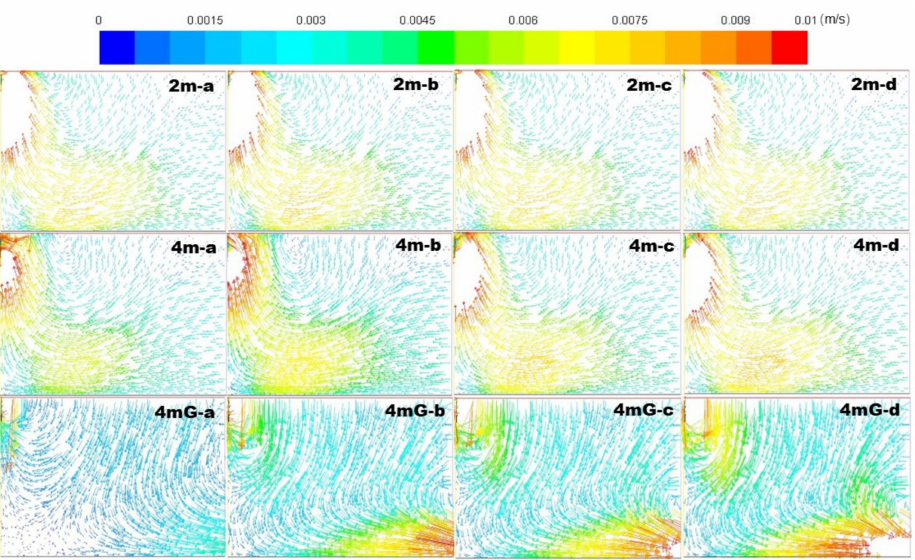
Figure 3. Velocity distribution of different gas inlet velocities (e.g., a, b, c and d are expressed as 0.03, 0.07, 0.10 and 0.15 m/s, respectively) produced by different lifts (e.g., 2m, 4m and 4mG are expressed as 2m-Lift, 4m-Lift, and